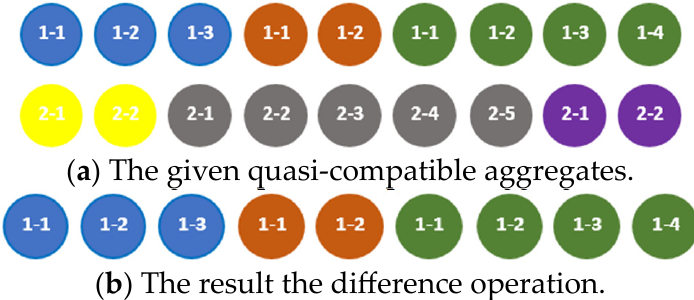
Figure 12. An example of applying the difference operation to two incompatible aggregates.